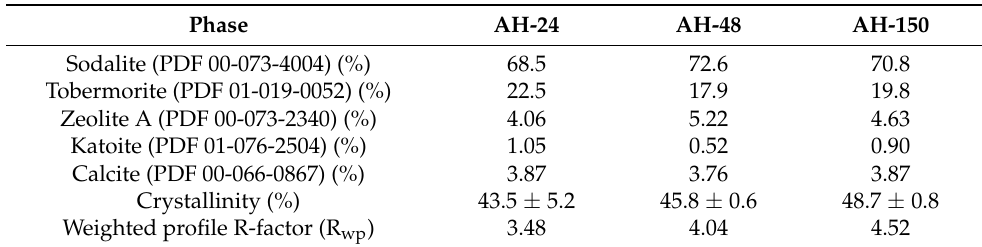
Table 4. Compositions of the hydrothermal reaction products of amber container glass and waste aluminium